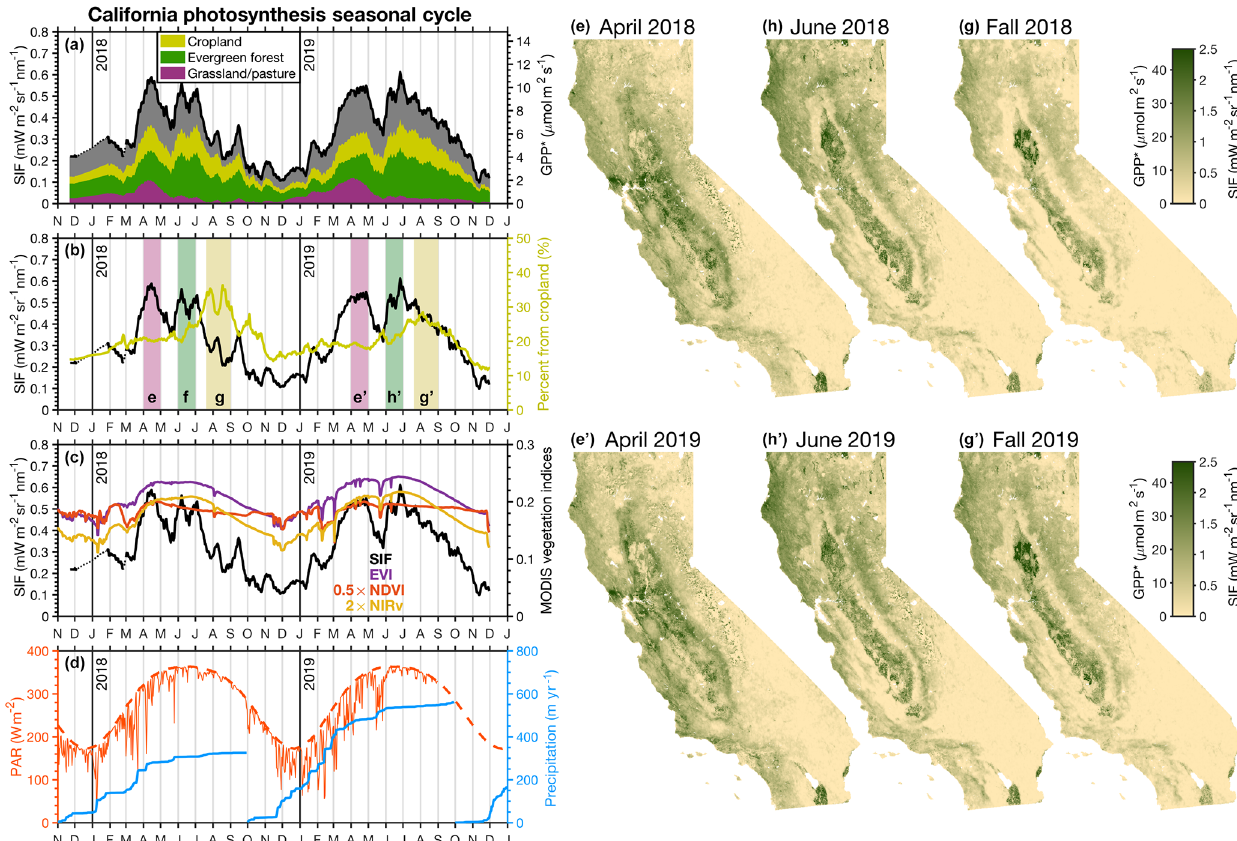
Figure 6. Seasonal cycle of photosynthesis in California. Panel (a) shows the statewide mean SIF (black line) at 13:30PST from Novem- ber 2017 to November 2019 broken down by the contributions coming from cropland (yellow), evergreen forests (green), grasslands or pastures (purple), and other (gray). Rice is included in cropland here. Land types are taken from the 2018 CropScape database shown in Fig. 1. The right axis shows the estimated GPP ∗ based on comparison with AmeriFlux sites in California. Panel (b) shows the percentage of SIF coming from cropland (yellow). Vertical bars indicate the time periods with corresponding spatial plots in panels (e) – (g (cid:48) ) . Panel (c) shows the vegetation indices (NDVI, EVI, and NIR v ) from MODIS over the same time period. Panel (d) shows clear-sky PAR over California at 13:00PST (dashed red line), surface PAR estimated from the ERA-Interim reanalysis (thin red line), and cumulative precipitation over the water year from the Global Precipitation Measurement (GPM) satellite (blue). Panels (e) – (g (cid:48) ) show the spatial patterns of SIF for the time periods indicated in (b)